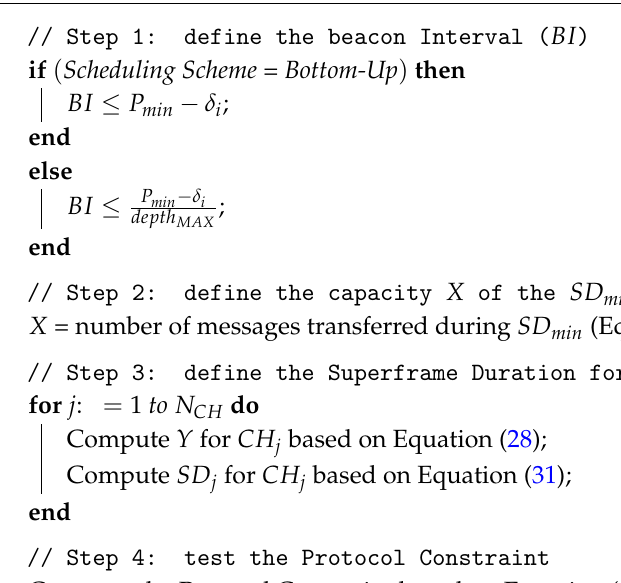
Algorithm 1: Load-SDA